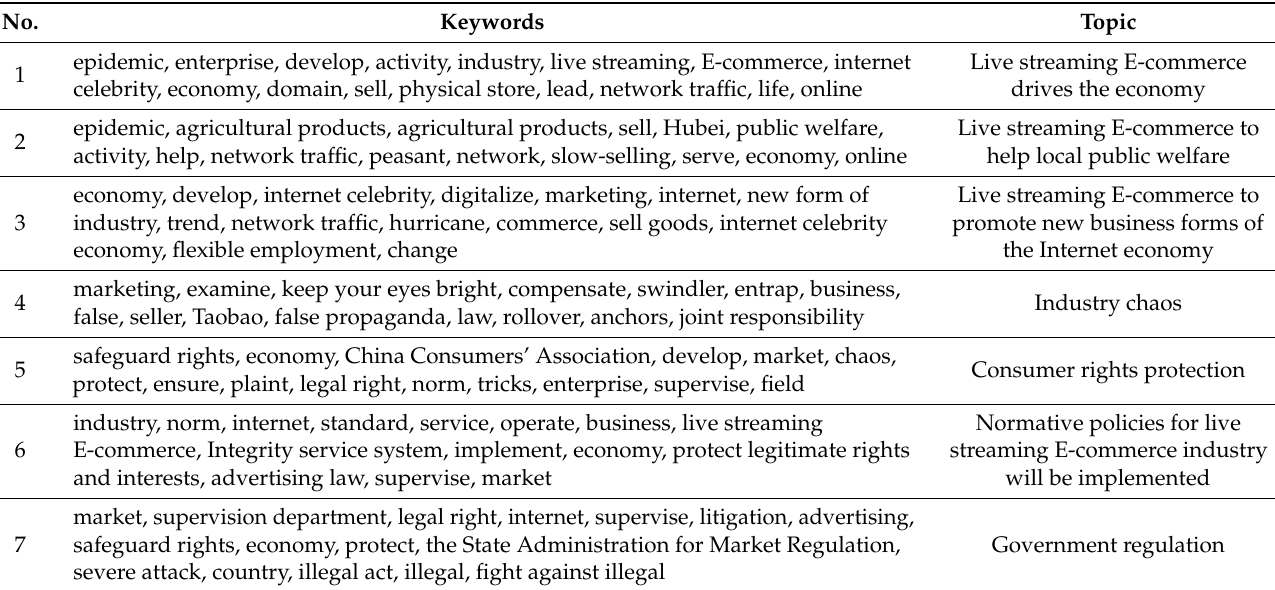
Table 5. Online HDP models before policy